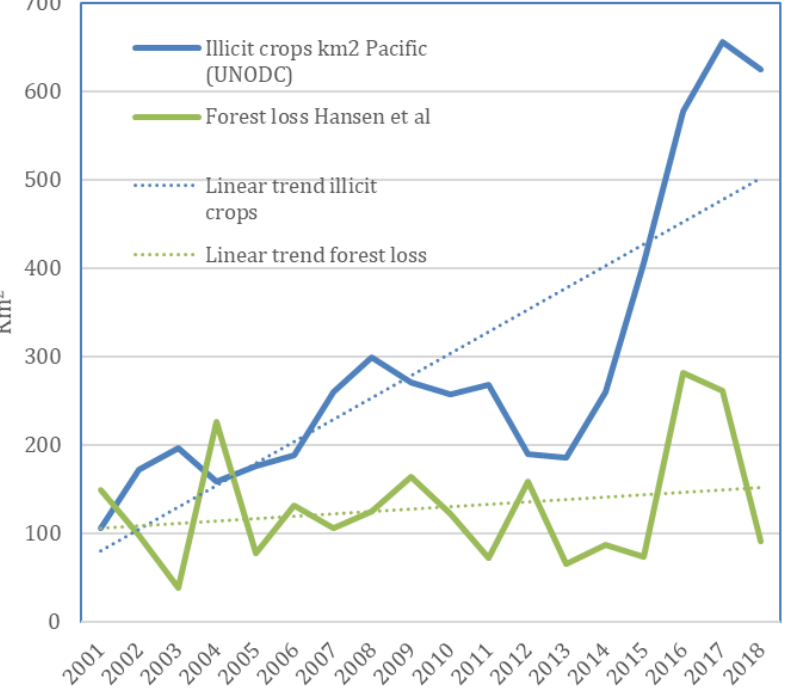
Figure 5. Patterns of total coca crops estimated by the United Nations Office on Drugs and Crime [51,53,58] and Hansen et al. [18] estimated deforestation.